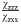
A) Histograms of χzzzχzxx values obtained for tissue sections of subcutaneously implanted aldehyde/sulfate, amidine, amino and dimethylamino polystyrene particles. The bars represent experimentally acquired data. The red line is the bimodal Gaussian fit to the data. B) Collagen type III content of fibrotic capsules surrounding subcutaneously implanted polystyrene particles.